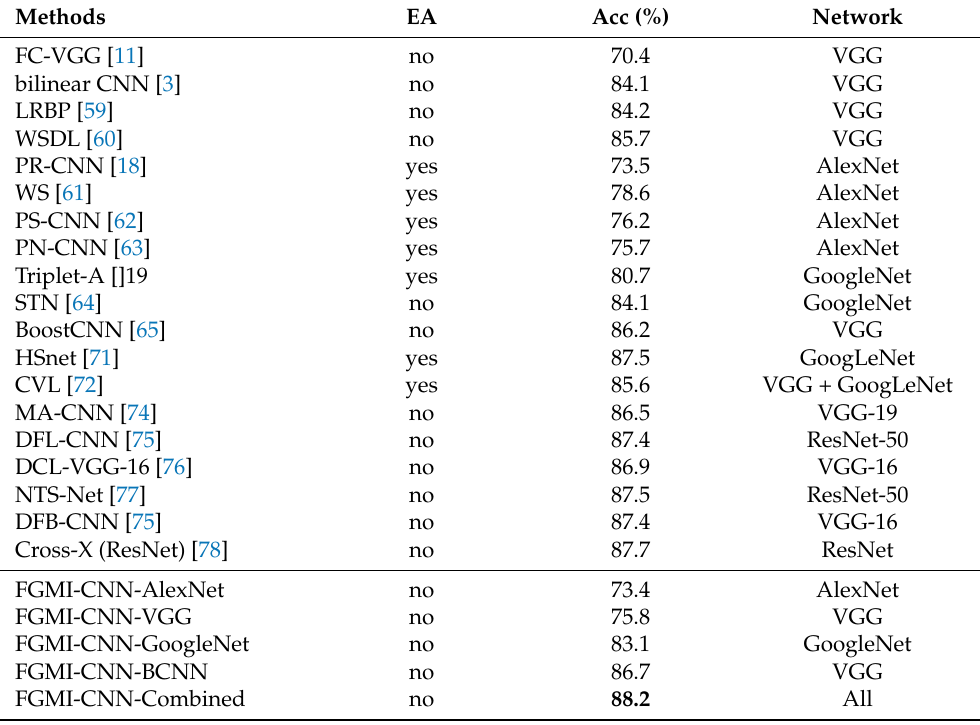
Table 3. Fine-grained classification performances of FGMI-CNN and other baseline methods on the CUB-200-2011 dataset. FGMI-CNN-AlexNet, FGMI-CNN-VGG, FGMI-CNN-GoogleNet, and FGMI-CNN-BCNN represent the proposed method combined with the prelearned AlexNet, VGG, GoogleNet, and Bilinear CNN models, respectively. FGMI-CNN-Combined represents the proposed method combined with AlexNet, VGG, GoogleNet, and Bilinear CNN jointly. EA—extra annotation.